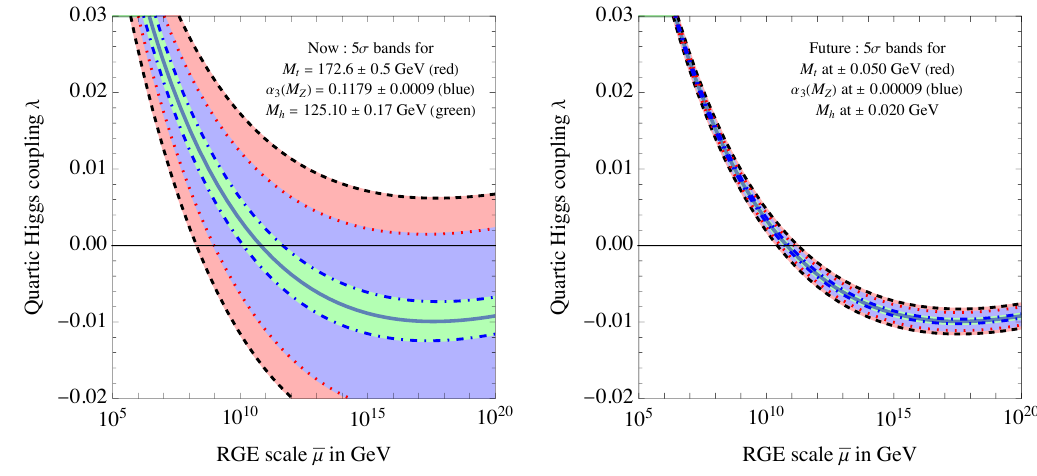
Figure 1 . Running of the quartic Higgs coupling, that determines the Higgs potential and its insta- bility scale. The ± 5 σ bands associated with the uncertainty in the top quark mass M dashed gray, those associated to α